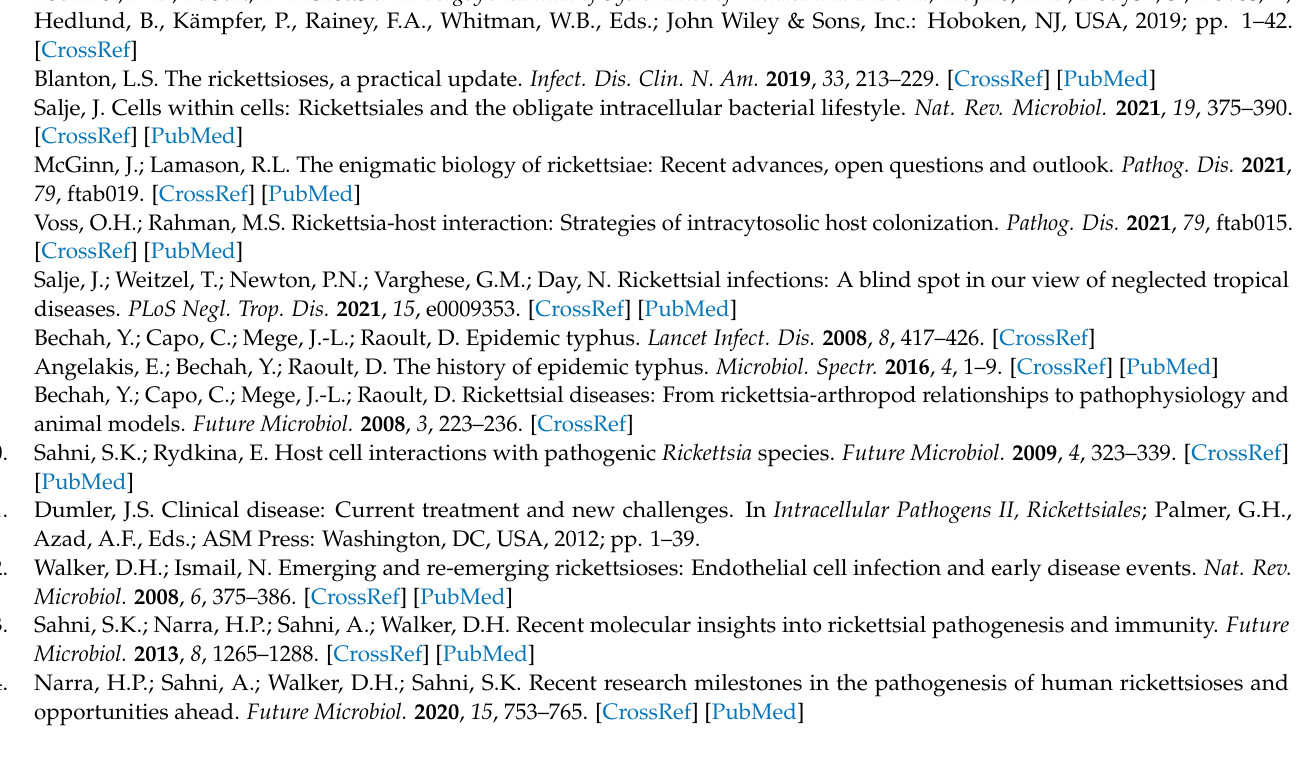
legend; Figure S3: Results of ethidium bromide staining in experiment 72; Table S1: Data for Figure 1; Table S2: Rickettsial infection data for Figure 1; Table S3: Data for Figure 3; Table S4: LDH release data for Figure 3, Taables 1 and S6; Table S5: Rickettsial infection data for Figure 3; Table S6: LDH release with lower PEG concentrations; Table S7: LDH release after removal of